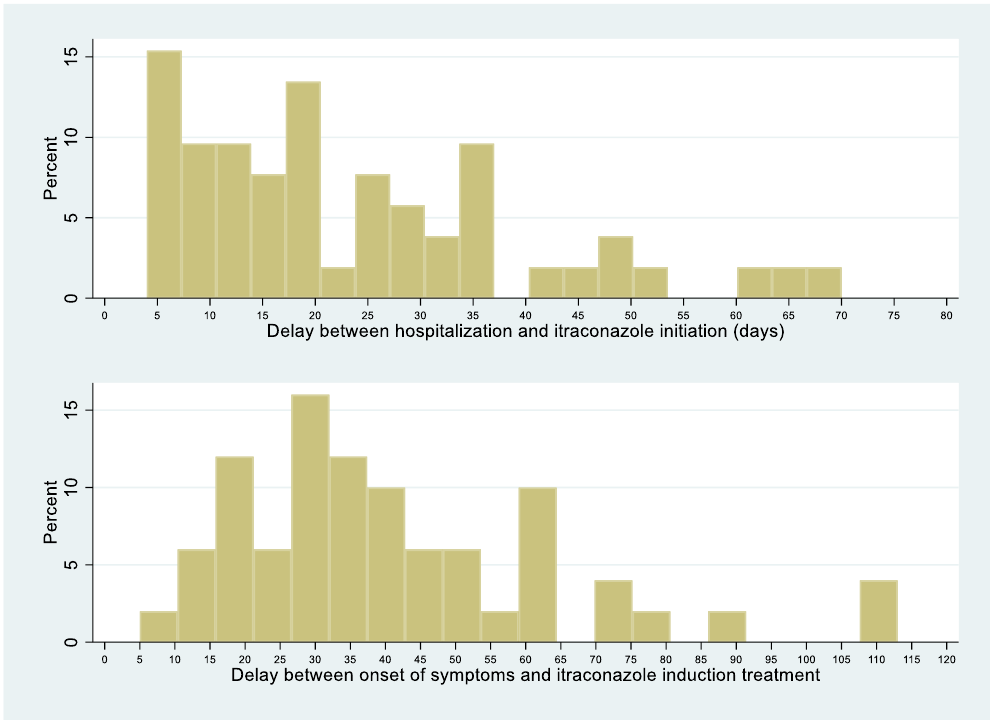
Figure 6. HIV-associated disseminated histoplasmosis: delay between initial symptoms, hospitalization, and itraconazole initiation.